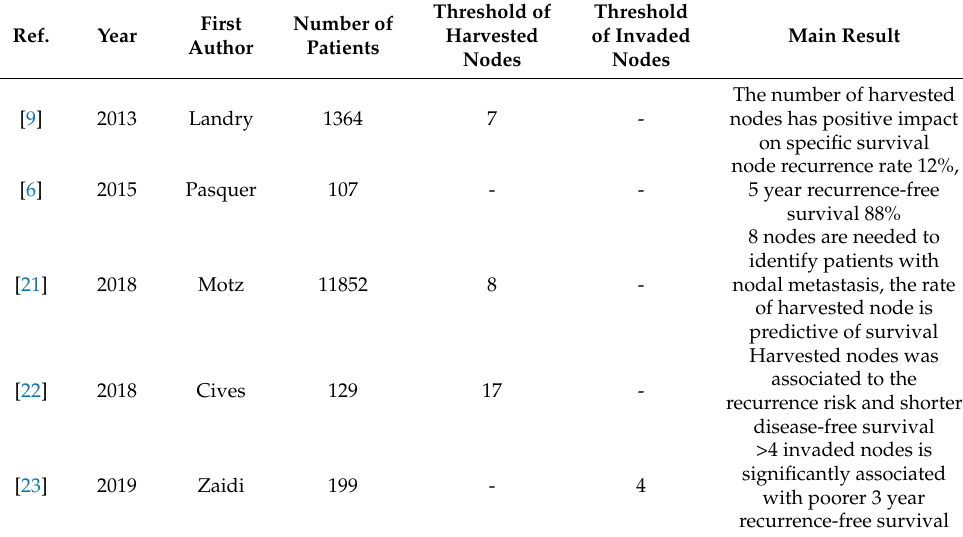
Table 1. Summary of extensive lymphadenectomy literature.